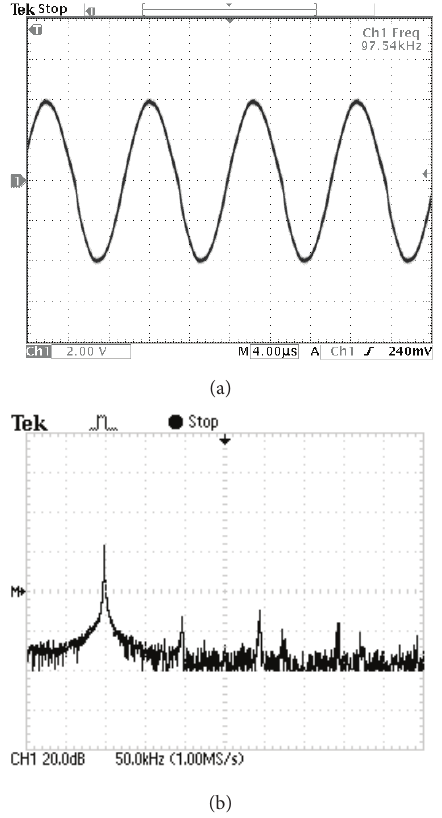
Figure 6: Experimental results for the circuit (Figure 4(a)): (a) output waveform and (b) corresponding frequency